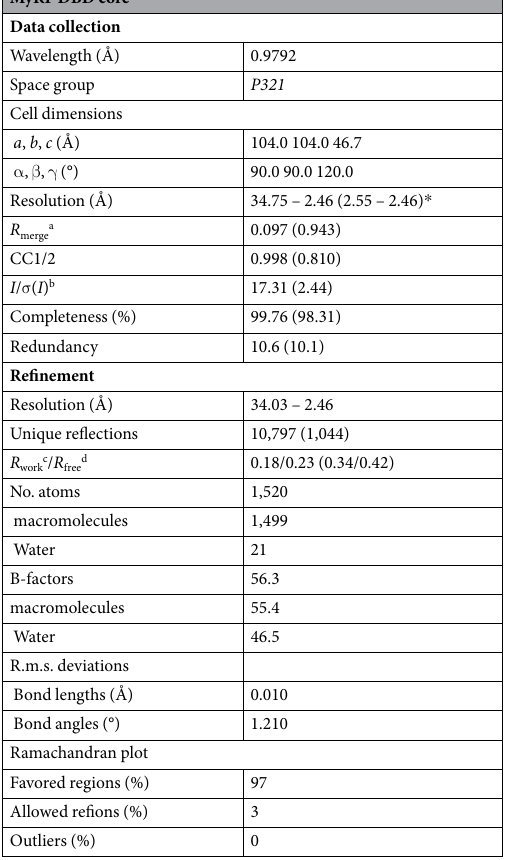
Table 1. Data collection and refinement statistics. * Values in parentheses are statistics for highest resolution shell. a